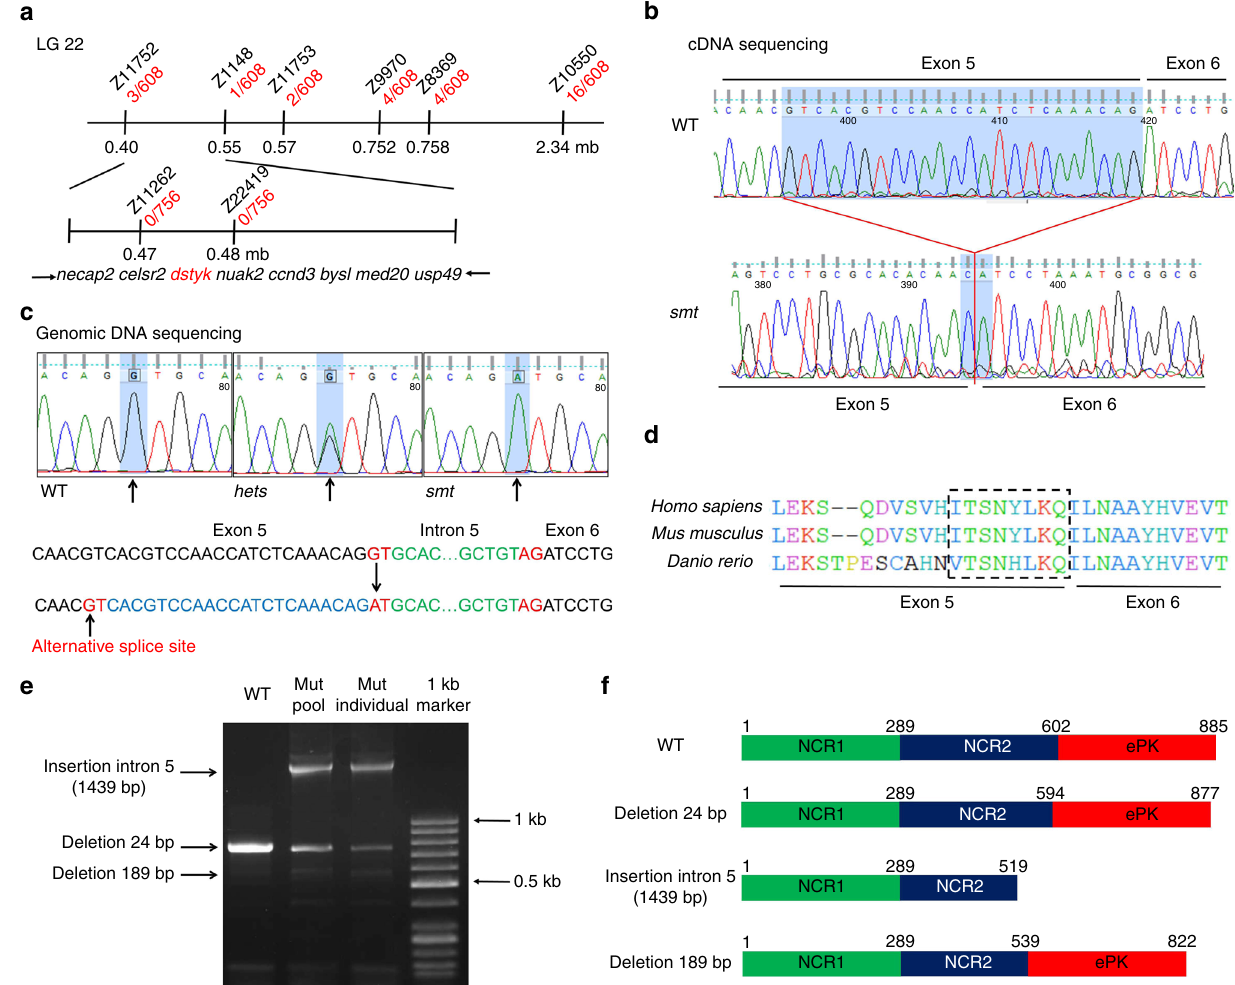
Fig. 2 Smt mutants encode alleles of dstyk . a Genetic map of the candidate region on chromosome 22 (LG 22). Number of recombinants are depicted in red, and SSLP markers used for mapping are in black. b Sequencing of cDNA revealed that smt mutants had a 24 bp deletion at the end of exon 5 in dstyk coding sequence. c Genomic DNA sequencing revealed smt mutants had a dstyk G → A transversion in the fi rst base of intron 5. Heterozygous smt is presented as hets. An alternative splice site is show in exon 5. d The mutation region of dstyk is evolutionally conserved across different species. Dotted box represents mutated amino acid. e PCR ampli fi ed the splicing mutation region (764 bp) of dstyk coding sequence showed more than three splicing types both in mutant pool and mutant individual. Arrows on the left indicate three different splicing types from agarose gel electrophoresis. f Diagramed DSTYK proteins structures of WT and three different predicted mutant proteins. WT DSTYK is comprised of two non-catalytic regions (NCR) and a eukaryotic protein kinase catalytic domain (ePK). Source data are provided as a Source Data fi